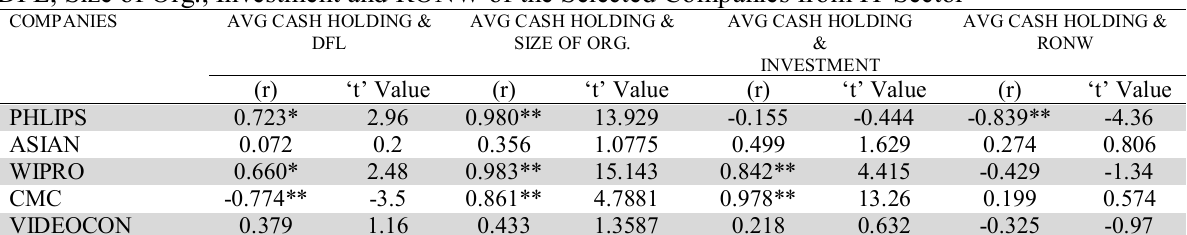
Statement Showing Karl Pearson’s Simple Correlation Analysis between AVG Cash Holding and DFL, Size of Org., Investment and RONW of the Selected Companies from IT Sector COMPANIES